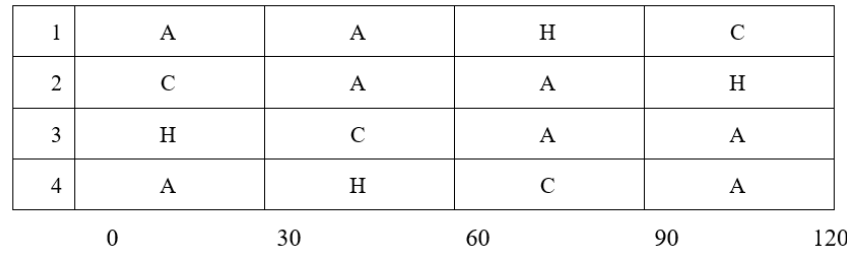
Figure 2. Four parallel beds ’ interconnection sequence (A: adsorption, C: cooling, H: heating).